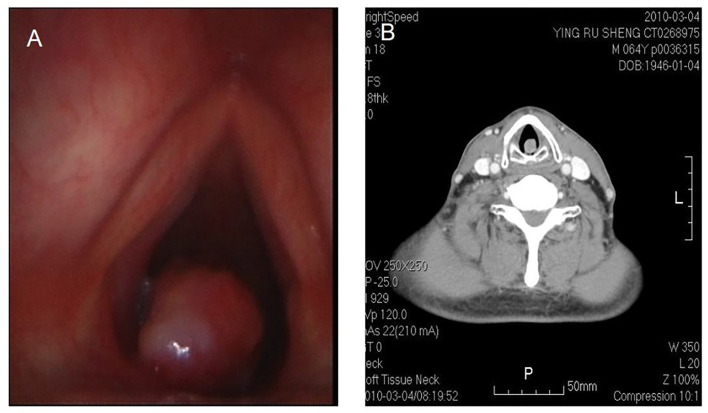
Fibrosarcoma in throat. Laryngoscope shows a nodulated neoplasm in the left posterior wall of hypolarynx, with surface relatively flattening (A). CT also shows that CT a nodulated neoplasm in infraglottic portion, with medium isotropical enhancement after contrast. The lesion is connected with posterior wall (B).